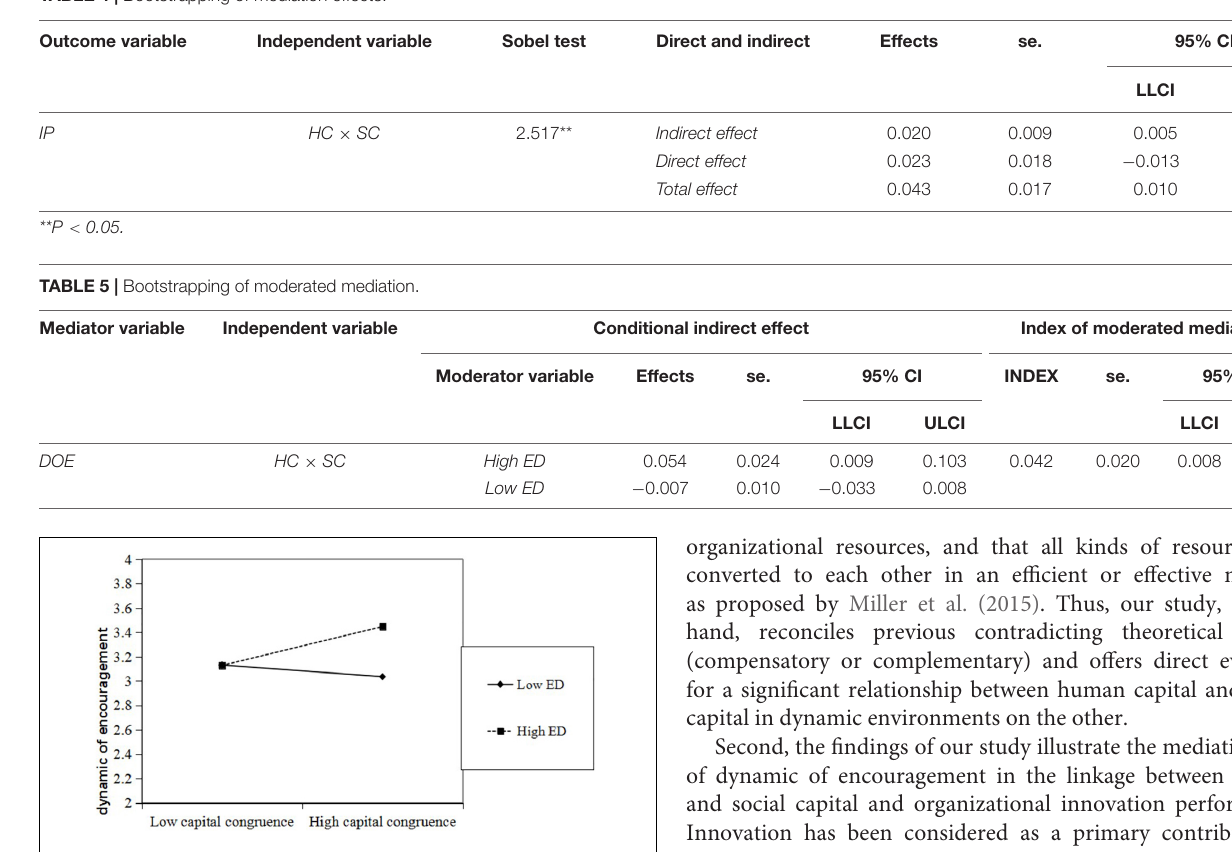
FIGURE 5 | Effects of the interaction between capital congruence and environmental dynamism on dynamic of encouragement.